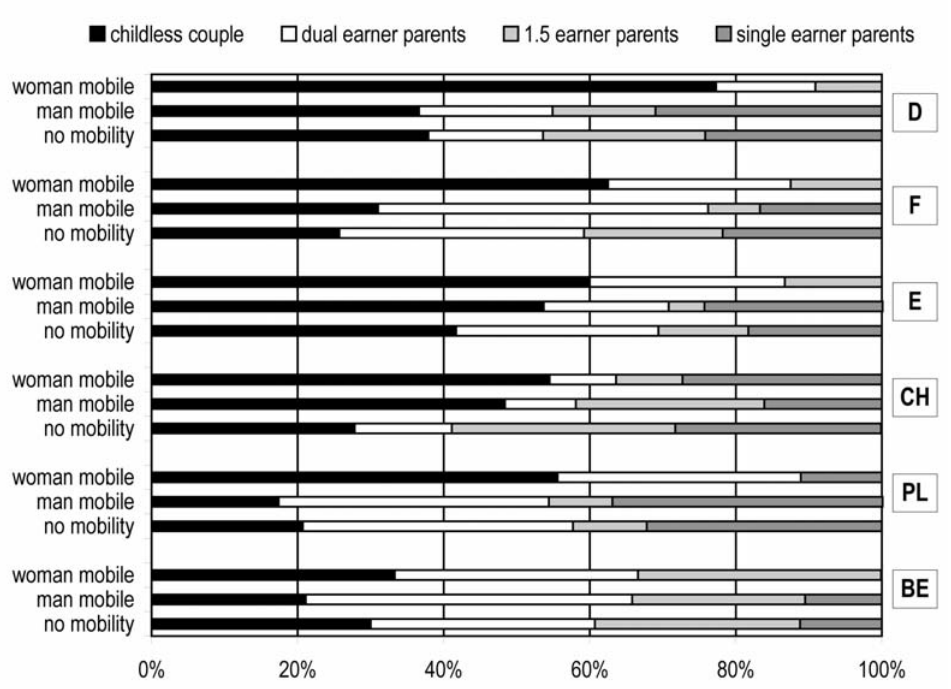
Couples’ childlessness and number of jobs by job